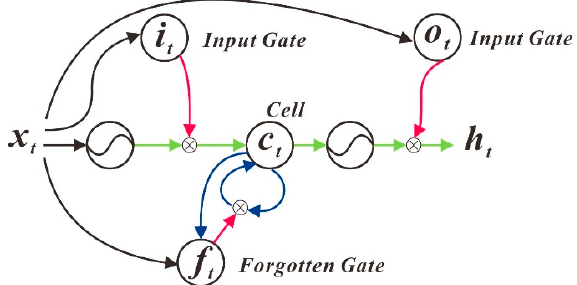
Figure 8. Long Short-Term Memory (LSTM) structure diagram.